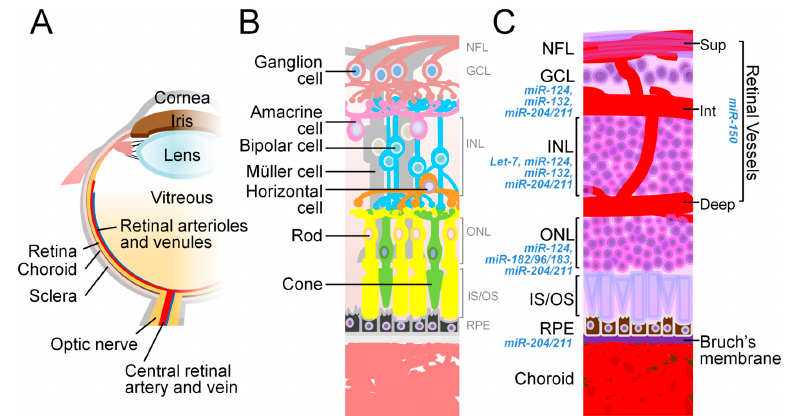
Figure 2. The anatomy of the eye and relevant miRNAs. ( A ) The schematic diagram illustrates the main structures of the human eye. ( B ) The schematic representation of the cell types in the neural retina depicts their cellular connections (including ganglion cells, amacrine cells, bipolar cells, horizontal cells, as well as rod and cone photoreceptors) and supporting cells (Müller cells and RPE). ( C ) A cross section of the eye shows the laminar organization of the nuclear layers (GCL, INL, and ONL), the retinal vasculature, and segments of photoreceptors (IS/OS). The RPE monolayer, with Bruch’s membrane underneath, is located between the neural retina and the choroid complex. miRNAs that regulate the physiological functions or pathological conditions related to each retinal neuronal and vessel layers, and RPE, are listed next to respective histological structure. Deep, deep layer of retinal vessels; GCL, ganglion cell layer; INL, inner nuclear layer; Int, intermediate layer of retinal vessels; IS/OS, inner/outer segments; ONL, outer nuclear layer; RPE, retinal pigment epithelium; Sup, superficial layer of retinal vessels. Figure adapted from “Animal models of ocular